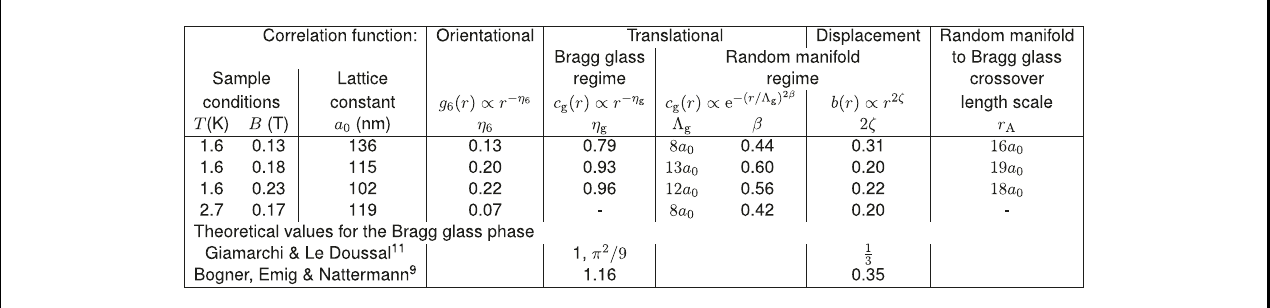
The topologically pristine Bragg glass phase is predicted by elastic theory with weak underlying disorder 11 . It has quasi-long-range positional order comprising of logarithmically growing displacements b ( r ) ∝ ln r and algebraically decaying translational correlations c g ð r Þ / r (cid:2) η g at large length scales r > r A . At smaller scales r < r A , correlations show the behaviour of a random manifold with b ( r ) ∝ r 2 ζ and c asymptotic regime is the fi rst to be suppressed as the vortex ensemble